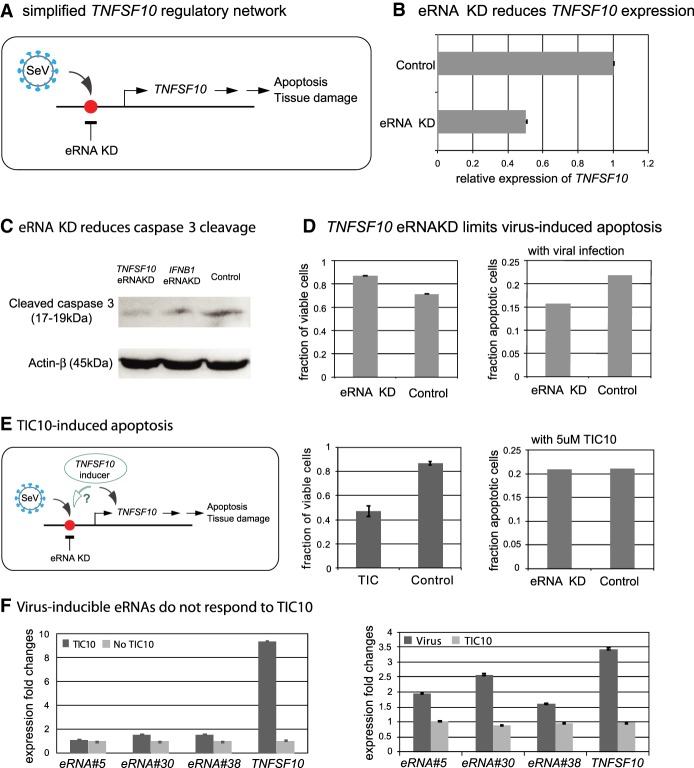
Effect of selective inhibition of TNFSF10 by eRNA knockdown on virus-induced apoptosis. (A) Simplified representation of the TNFSF10 regulatory network. (B) Relative expression of TNFSF10 in eRNA knockdowns (#5, #30, and #38, triple eRNA KD) and control cells. Triple KD of eRNAs regulating the TNFSF10 results in loss of TNFSF10 expression. (C) Western blot using cleaved caspase 3 antibody to assess apoptosis. Stronger signal of cleaved caspase 3 indicates higher fraction of apoptotic cells. As an internal standard, beta actin was used. For an uncropped image of these blots, please see Supplemental Figure S8. (D) Cell viability by live cell counts (left panel) and apoptotic cell counts (right panel) for TNFSF10 eRNA KD and control cells are shown. (E) Regulation of apoptosis by TIC10- or virus-induced TNFSF10 expression. Possible mechanism through eRNA or direct gene activation is shown in the left panel. Cell viability by live cell counts (middle panel) for TIC10-treated cell, control cell, and apoptotic cell counts (right panel) for eRNA KD (triple KD) and control KD upon TIC10 treatment for 48 h. (F) TNFSF10 and its three eRNAs expression fold changes with or without TIC 10 treatment for 48 h (left panel), and with SeV or TIC10 treatment for 9 h (right panel).